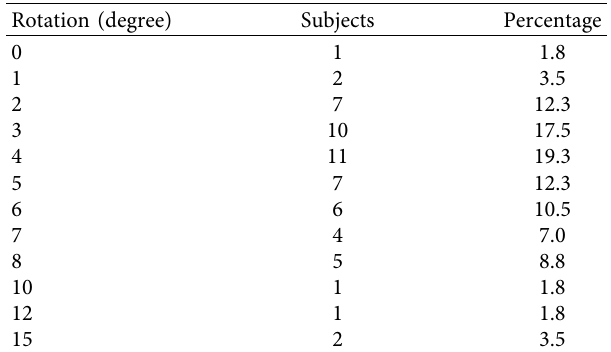
Table 3: Rotation after cataract surgery with a high-power toric intraocular lens.